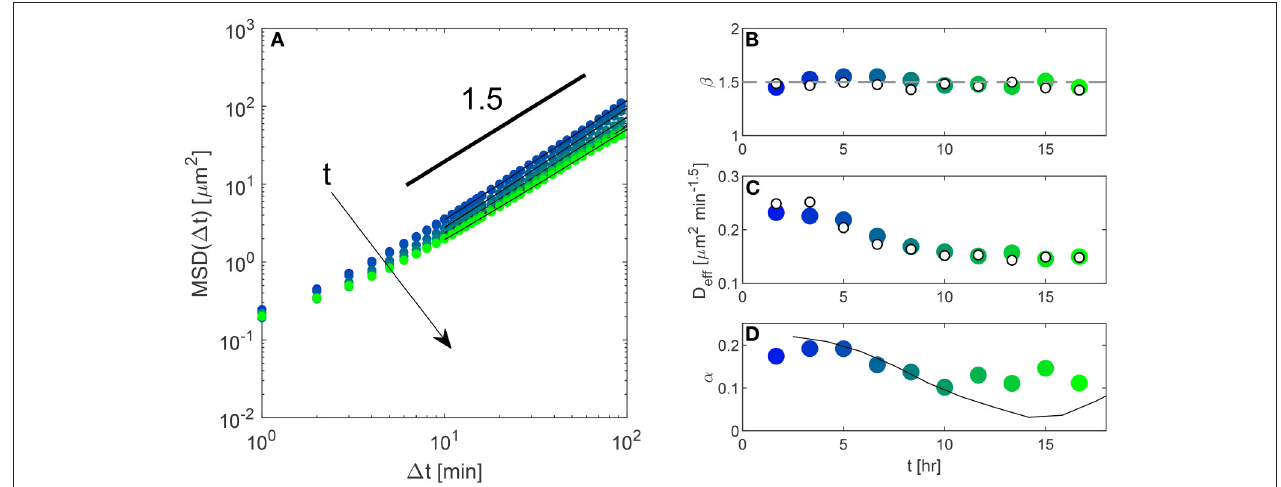
FIGURE 3 | (A) Symbols: mean squared displacement MSD obtained from DDM analysis (wide-field fluorescence imaging), performed over a time window of 200 min, at different time points over the course of the experiment. Continuous lines are best fitting curves to the date with the model given in Equation (13). (B) Temporal evolution of the exponent β describing the long-time scaling of the MSD (see Equation 13). Empty symbols are obtained from PT, filled symbols from DDM. (C) Temporal evolution of the prefactor D eff of the power-law describing the asymptotic behavior of the MSD (see Equation 13) . Empty symbols are from PT, filled symbols from DDM. (D) The relative amplitude α of the faster decay in the ISF (filled symbols) is compared with the fractional division rate (black continuous line). The latter is estimated by nuclear counting and has been rescaled by an arbitrary factor to make the comparison easier.